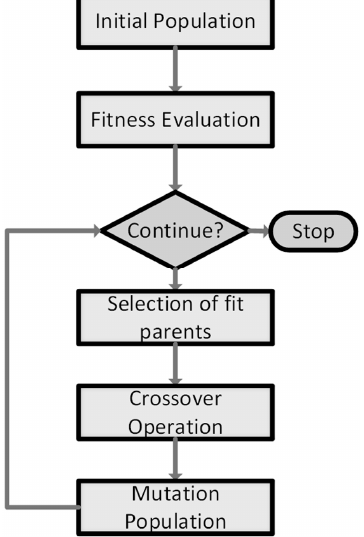
Figure 3. Flowchart diagram of a basic genetic algorithm (GA).